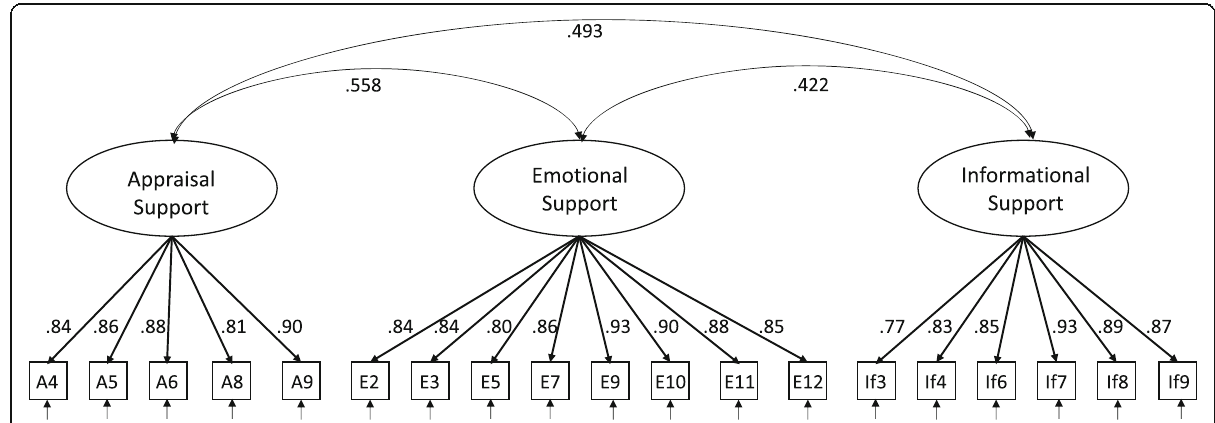
Fig. 1 Final three-factor CFA model. Instrument items (for text of items see Table 2) are represented by squares and factors are represented by ovals. The numbers associated with the double-headed arrows between the factors are the correlations between each factor. The numbers next to the one directional arrows are standardized factor loadings. Small arrows indicate error terms. P <0.001 for all